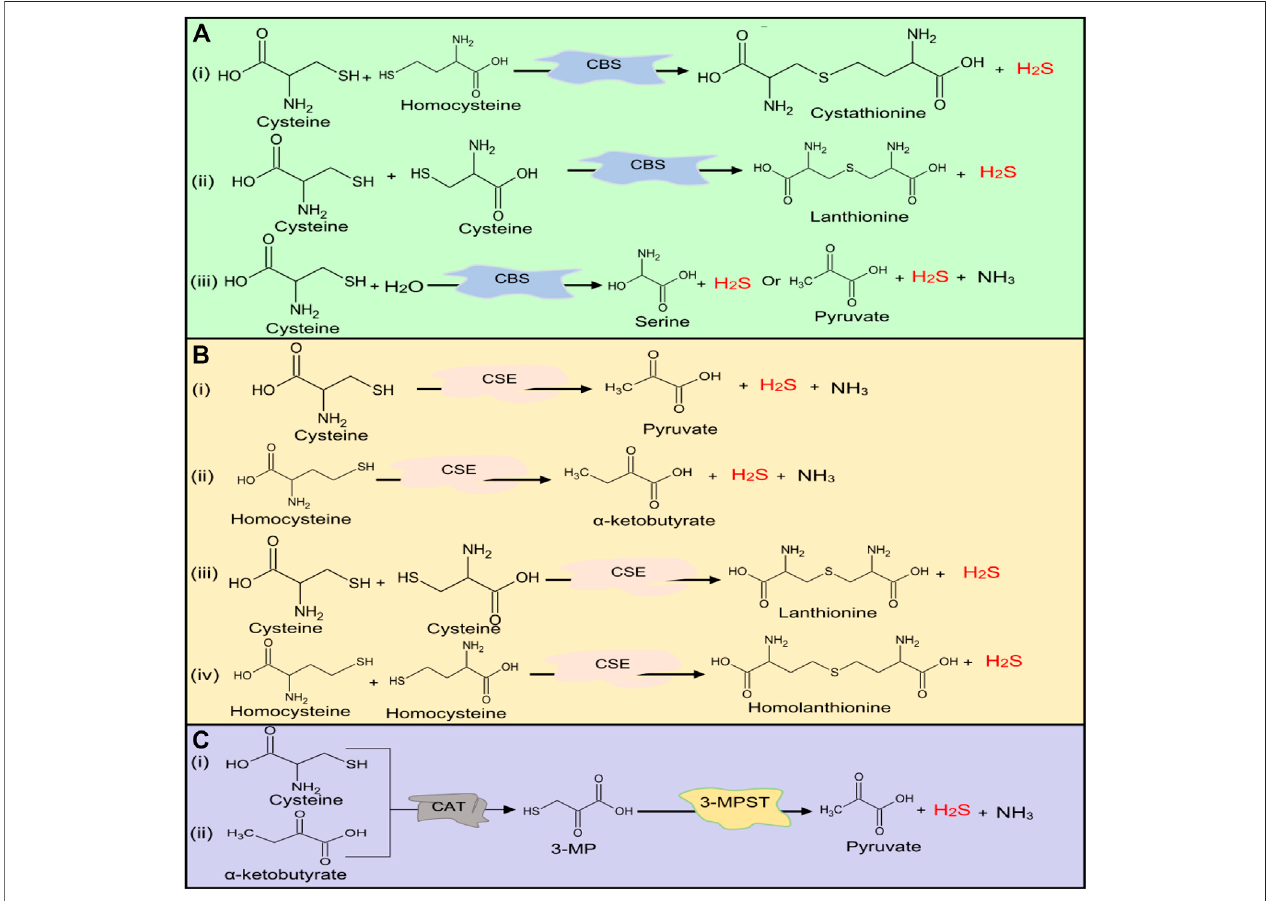
FIGURE1 | H 2 S production at normal physiologicalconditions inthe body by (A) CBS, (B) CSE,and (C) 3-MPST. Both CBS and CSE produce H 2 Sfrom cysteine and homocysteine, while 3-MPST produces H 2 S from 3-MP generated by CAT from Cys and α -ketobutyrate. H 2 S, hydrogen sul fi de, CBS, cystathionine β -synthase; CSE, cystathionine γ -lyase; 3-MPST, 3-mercaptopyruvate sulfurtransferase; 3-MP, 3-mercaptopyruvate; CAT, cysteine aminotransferase; Cys, cysteine.